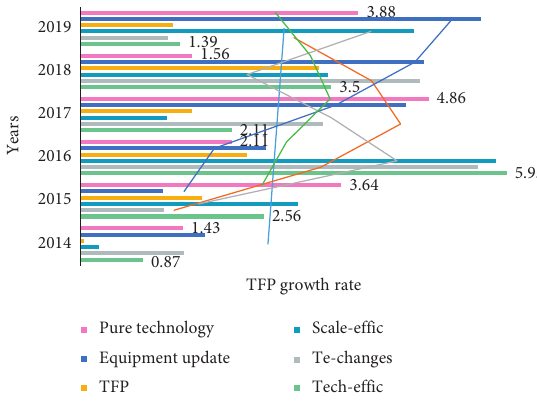
Figure 8: Net changes in technical performance and changes in scale performance. Table 3: 2014–2019 total factor productivity index.